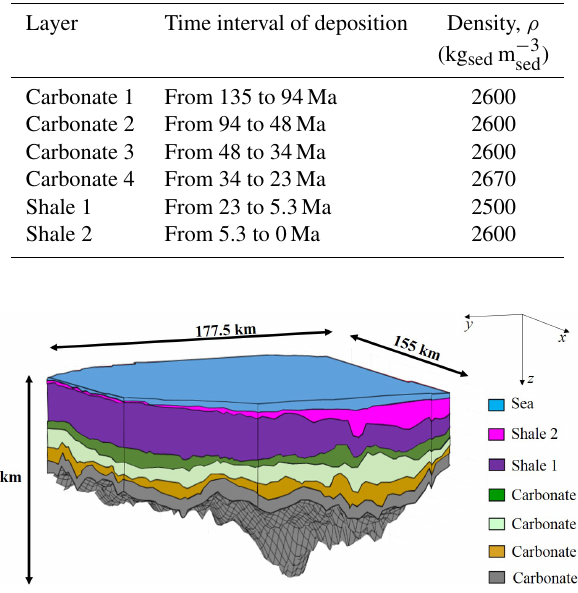
Figure 2. Sketch of the three-dimensional sedimentary basin setting considered at the present time, i.e., t = 0Ma.